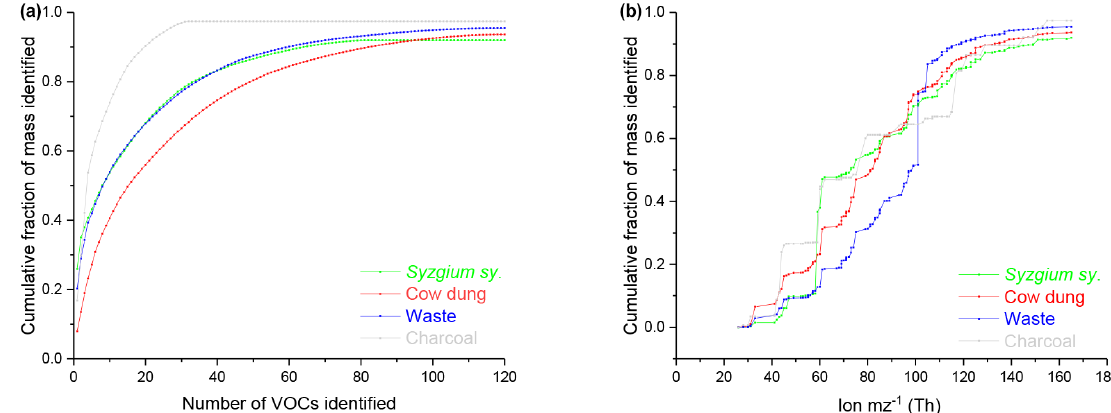
Figure 4. Cumulative NMVOC mass identified from PTR-ToF-MS compared with total NMVOC signal measured by PTR-ToF-MS with (a) ordered by decreasing NMVOC mass contribution and (b) ordered by ion mass. High quantification of emissions from charcoal was due to a low emission factor (2.4gkg − 1